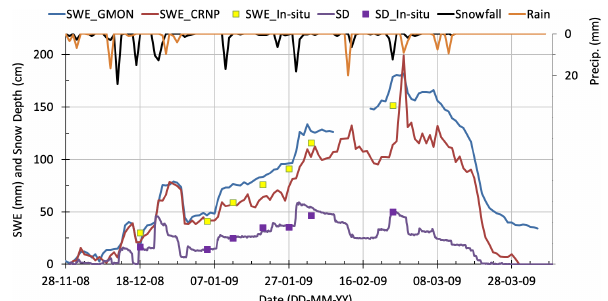
Figure 3. GMON- and CRNP-derived water equivalent of snow cover (SWE, mmw.e.), snow depth (SD, cm), and recorded daily solid and liquid precipitation (precip., mm, right-hand scale), in comparison to validation data (in situ) at the SIRENE site for the winter season of 2008–2009. Continuous SD measurements (pur- ple line) are from SR50AT-L, and SD in situ measurements (purple square; SD_In-Situ) are from snow pits. Open yellow squares cor- respond to manual in situ SWE measurements.